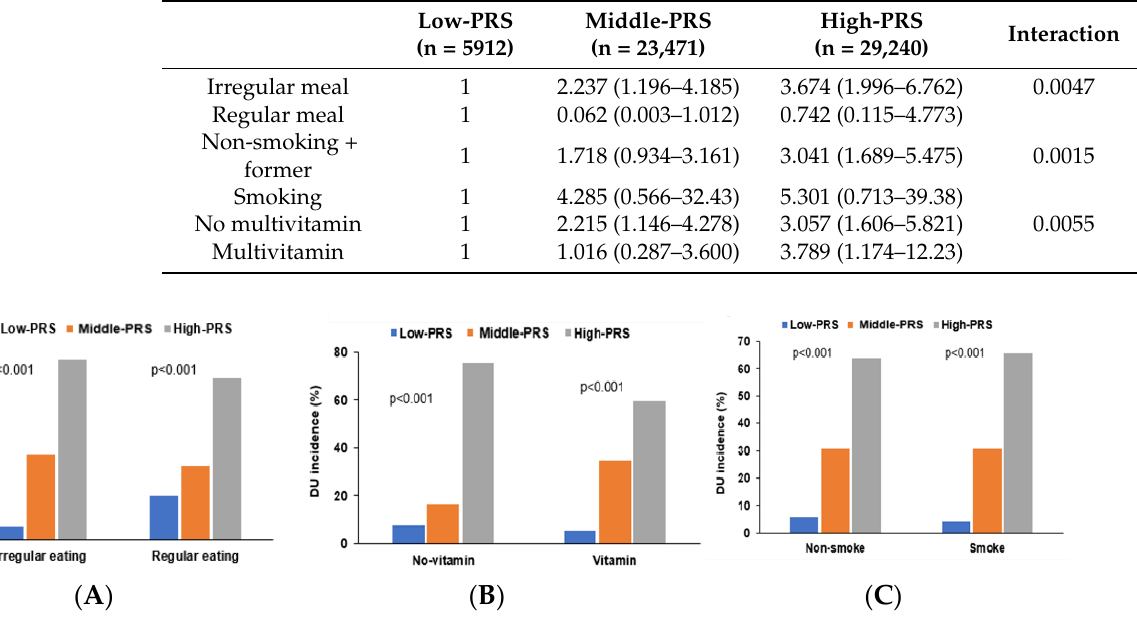
Table 6. Adjusted odds ratios for the duodenal ulcer risk by polygenetic risk scores of the best model (PRS) after covariate adjustments according to the patterns of lifestyles. Low-PRS Middle-PRS High-PRS Interaction (n = 5912) (n = 23,471) (n = 29,240)